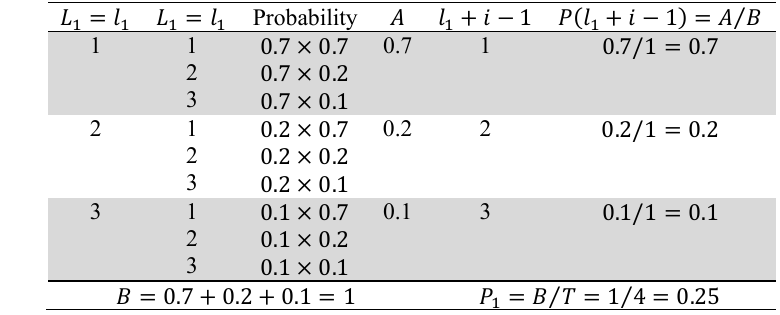
Based on Table 2 and Fig. 3, the demand between ordering and the 𝑖 (cid:3047)(cid:3035) period after the order arrives is determined as follows.  Demand between ordering and the 1 (cid:3046)(cid:3047) period ( 𝑖 = 1) after the order arrives is the demand during a lead time of {1,2,3}